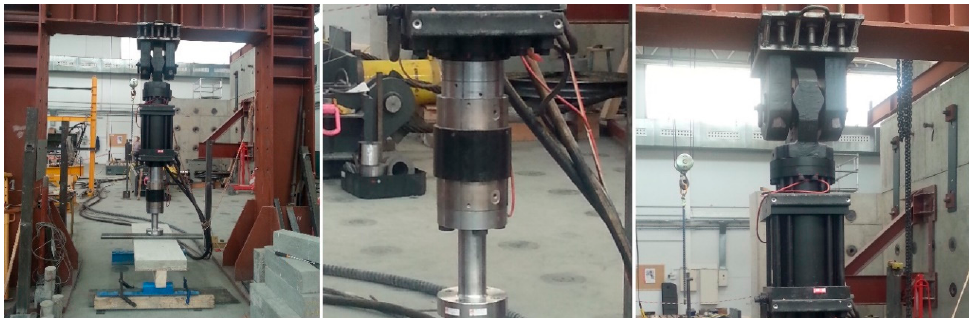
Figure 7. 1000 kN hydraulic press ( left ). Detail of actuator ( center ) and of transducer ( right ).